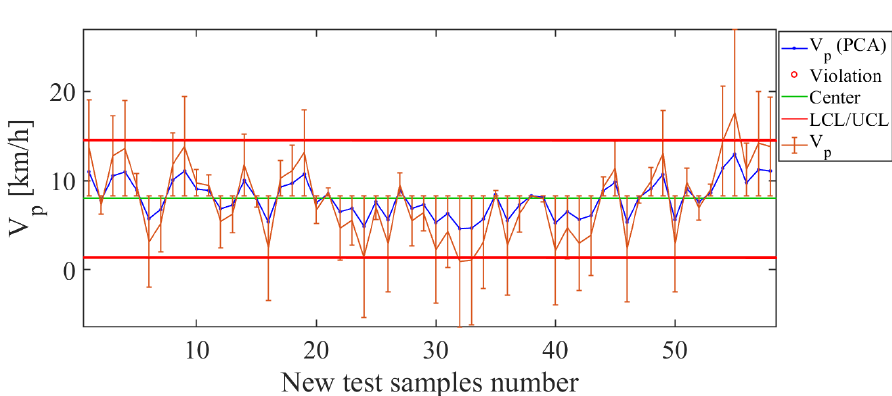
Figure 20. Soft-sensor response (control chart and error bars) for the operating condition V p . Note the low level of the estimates for values less than V p = 5